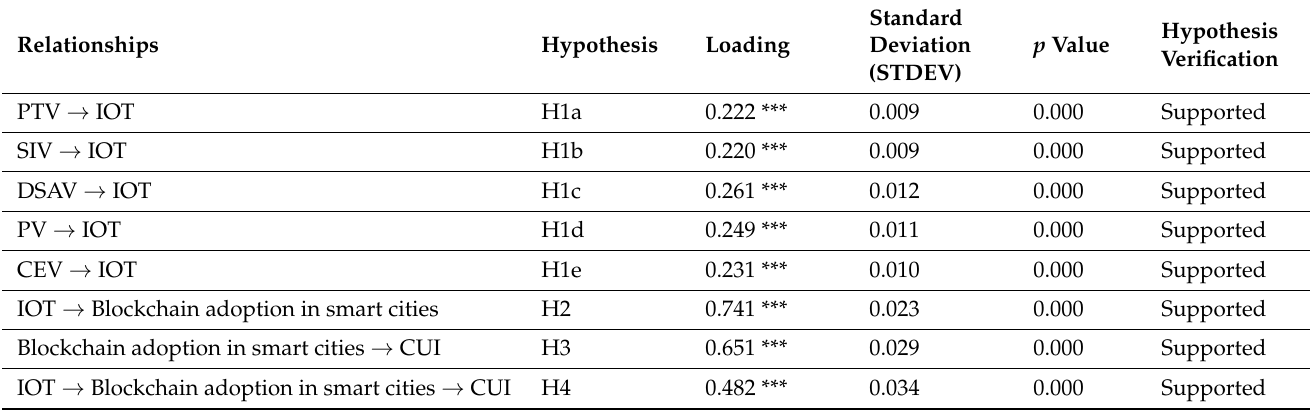
Table 5. Structural Model Results.